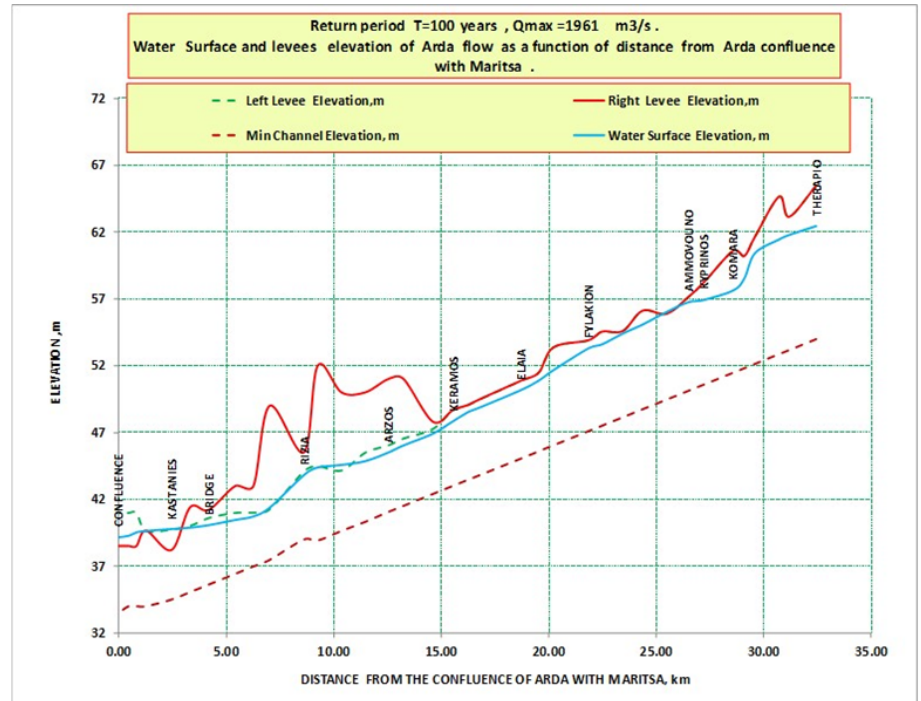
Figure 6. Bed of the river, free water surface, and left and right levees’ elevations in relation to the distance from the junction of the Arda and Evros rivers. The elevations of the left and right levees are almost the same from chainage 16 km to chainage 33 km.